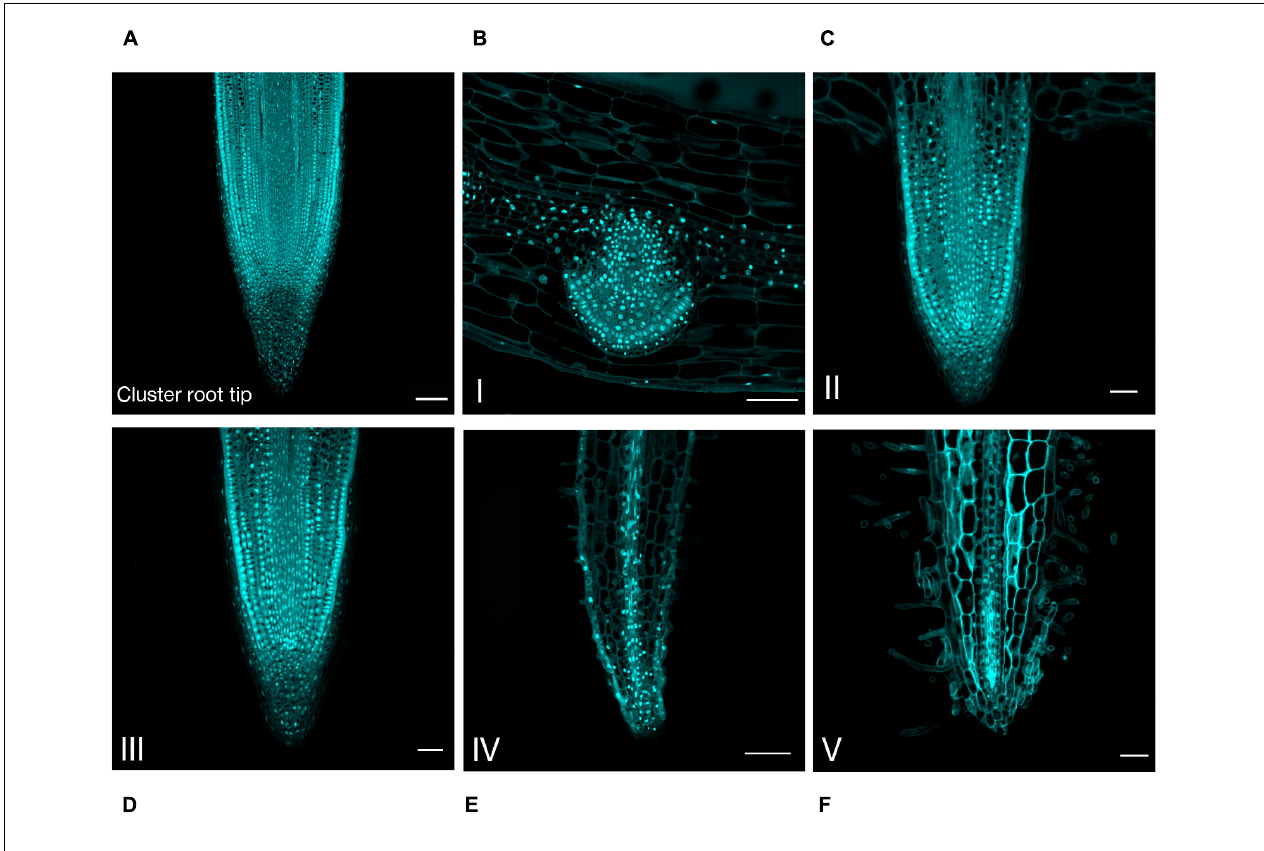
FIGURE 3 | Anatomical study of the cluster root tip, and rootlet tips at different stages of development. DAPI was used to stain 8- µ m thin longitudinal sections of (A) cluster root tip, and rootlet tips at (B) stage I, (C) stage II, (D) stage III, (E) stage IV, (F) stage V. Scale bars: (A–F) 50 µ